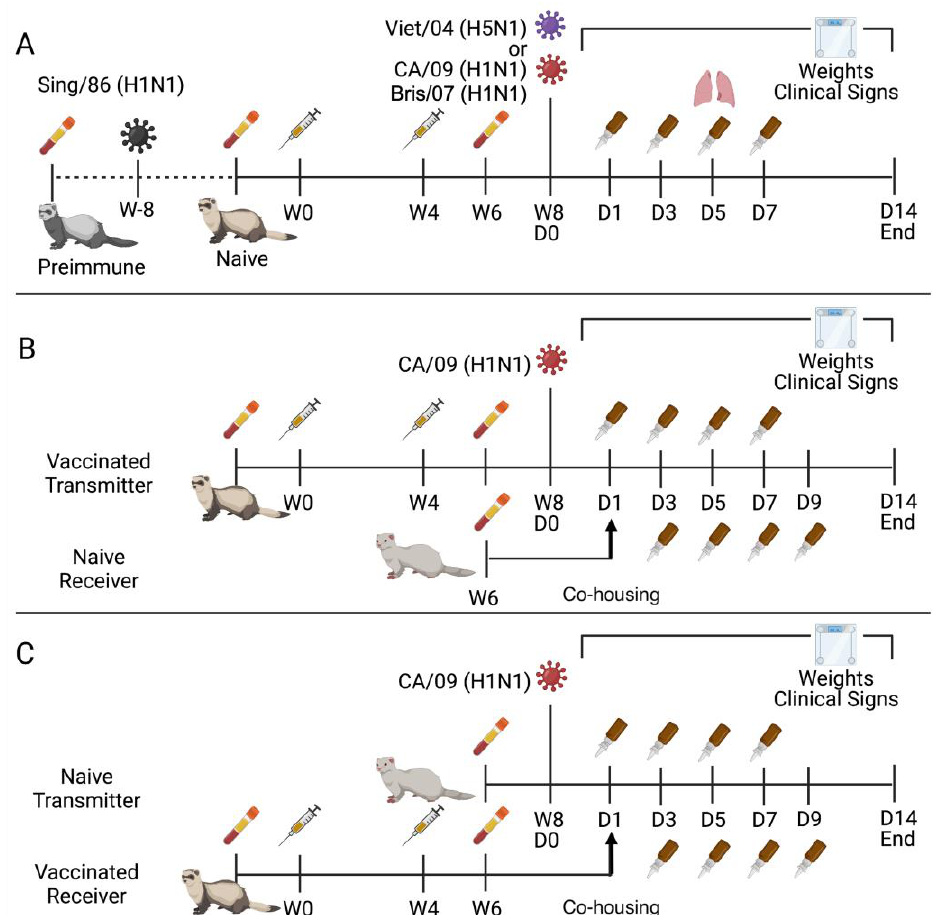
Figure 1. Naïve, pre-immune, and contact transmission ferret model design. Naïve or pre-immune ferrets were vaccinated with 15 µ g of adjuvanted recombinant protein in a prime-boost schema after pre-bleeding and pre-immunization if necessary ( A ). Animals were challenged with either Viet/04 or CA/09. On day 5 p.i., four animals were harvested for lung viral titers and histopathology for CA/09 challenge. Contact transmission between vaccinated transmitters and influenza naïve receivers was studied by vaccinating the transmitter with 15 µ g recombinant protein with adjuvant in a prime-boost, infecting with CA/09, and on day 1 p.i. co-housing the intranasally infected ferret with the naïve receiver after nasal wash ( B ). Contact transmission between influenza naïve infected transmitters and vaccinated receivers was similar, except the naïve ferret was infected and then the vaccinated ferret was co-housed on day 1 p.i. ( C ). Weights and clinical signs were recorded for all ferrets for a maximum of 14 days post-influenza exposure. Nasal washes were harvested on days 1, 3, 5, and 7 p.i. for intranasally infected animals and on days 3, 5, 7, and 9 p.i. relative to the day of infection for the transmitting ferret for the contact transmission